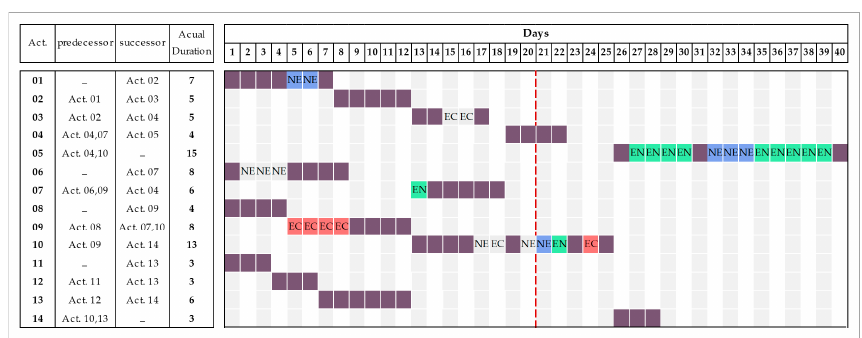
Figure 8. As-planned impacted schedule, period (35–39).